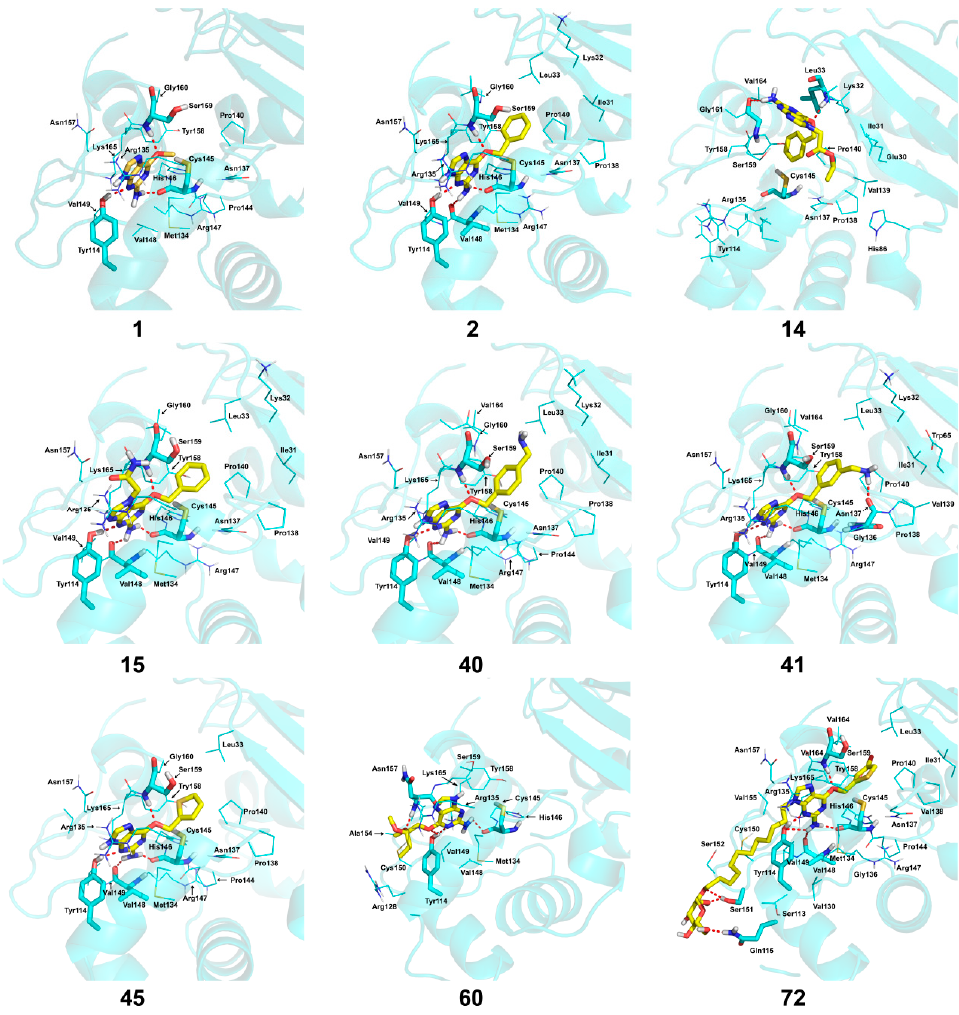
Figure 4. The optimal docking conformations of the representative molecules with MGMT protein (PDB entry: 1QNT). The protein is displayed as a cartoon model in cyan color. The ligands are depicted as stick models with yellow representing carbon atoms. The hydrogen bonds between ligands and receptor are represented by red dotted lines and the residues forming hydrogen bonds are presented in stick model with cyan for carbon atoms. The remaining residues in the active pocket are displayed as line models with cyan representing carbon atom. Nonpolar hydrogens were hidden. All figures were generated using PyMOL software (Educational version; www.pymol.org; DeLano Scientific, San Carlos, CA, USA).